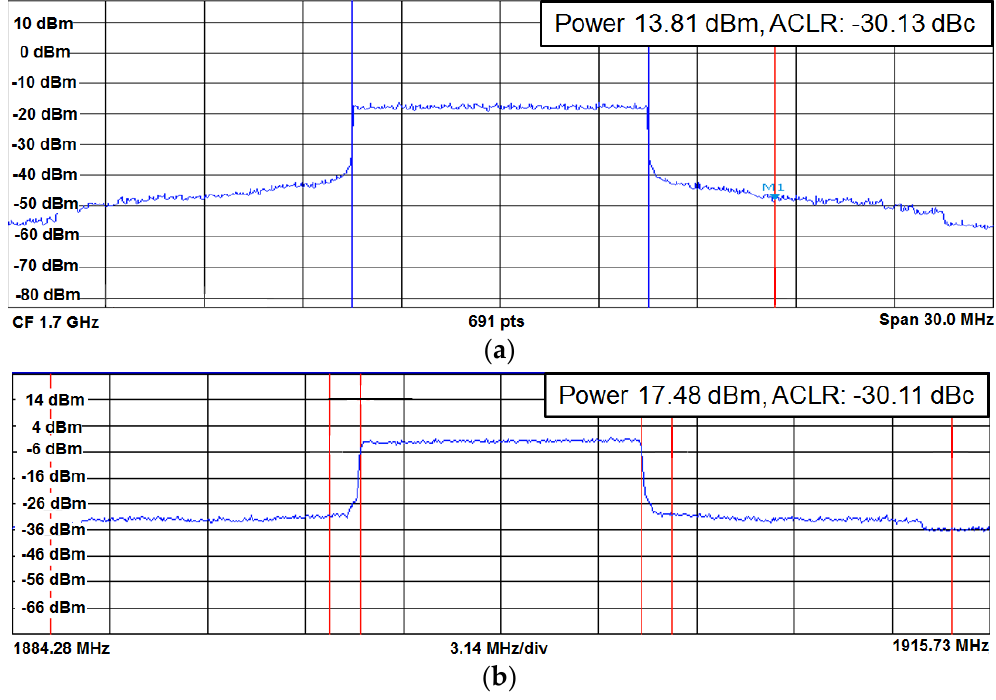
Figure 16. Measured PA output spectrum for the long-term evolution (LTE) signal: ( a ) 13.81 dBm with 2V DD = 3.6 V at 1.7 GHz; ( b ) 17.48 dBm with 2V DD = 3.8 V at 1.9 GHz.